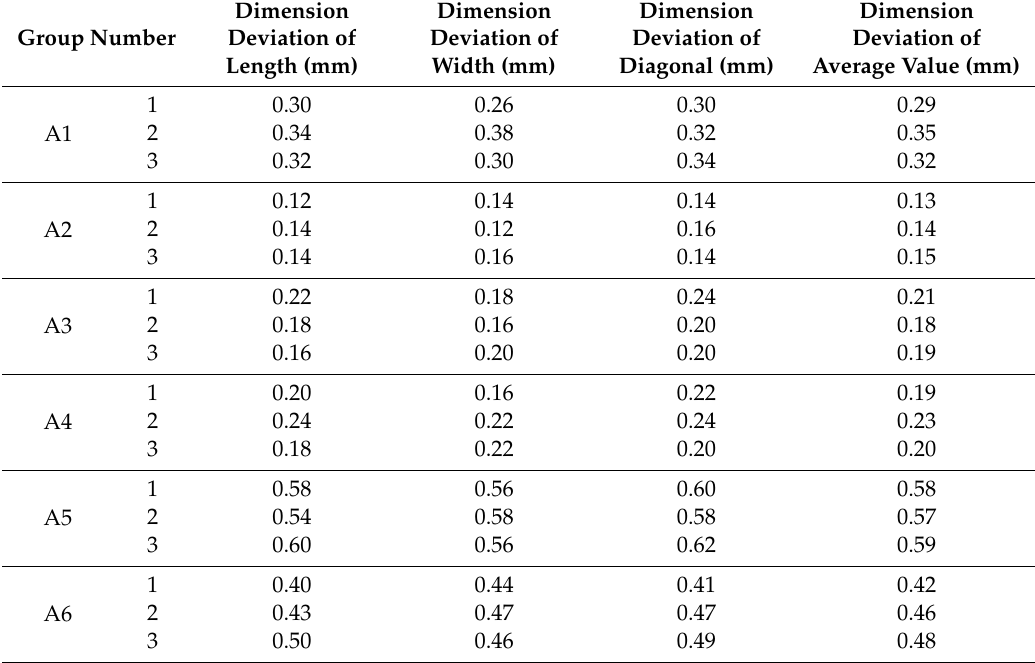
Table 3. Panel dimensional deviation of veneered RSP with di ff erent performance.